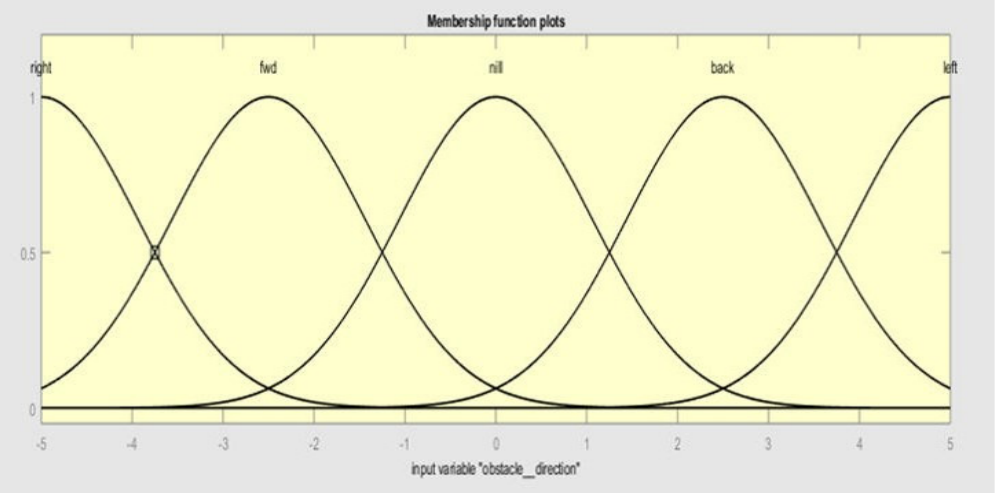
Figure 6. Membership functions of input 2 (obstacle direction).